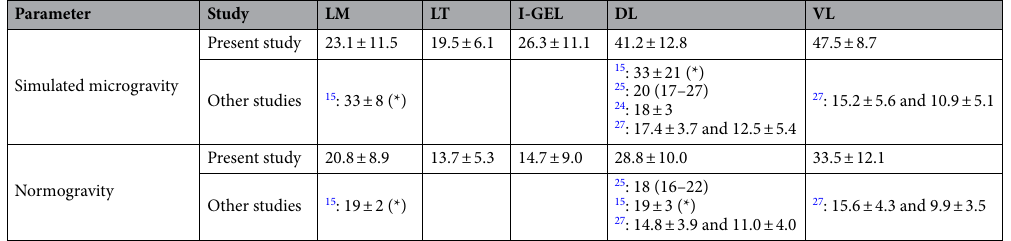
Table 3. Comparisons for time to ventilation [s] of other studies as compared to the present study. (*) This is the only study available with simulated microgravity underwater 15 . Other studies are technically limited to 21 s maximum time due to the parabolic